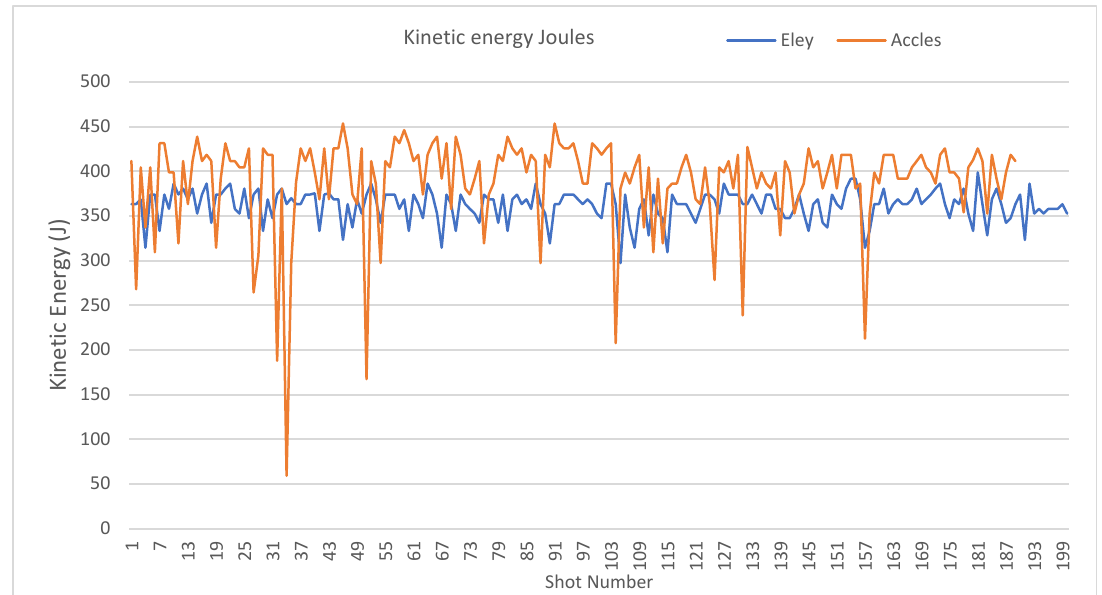
Figure 7. Plot of calculated kinetic energy (Joules) using recorded velocities 11.4 mm from the device. Lower AS head stamp momentum scores corresponding to rupture of the cartridge casing at the primer flange.